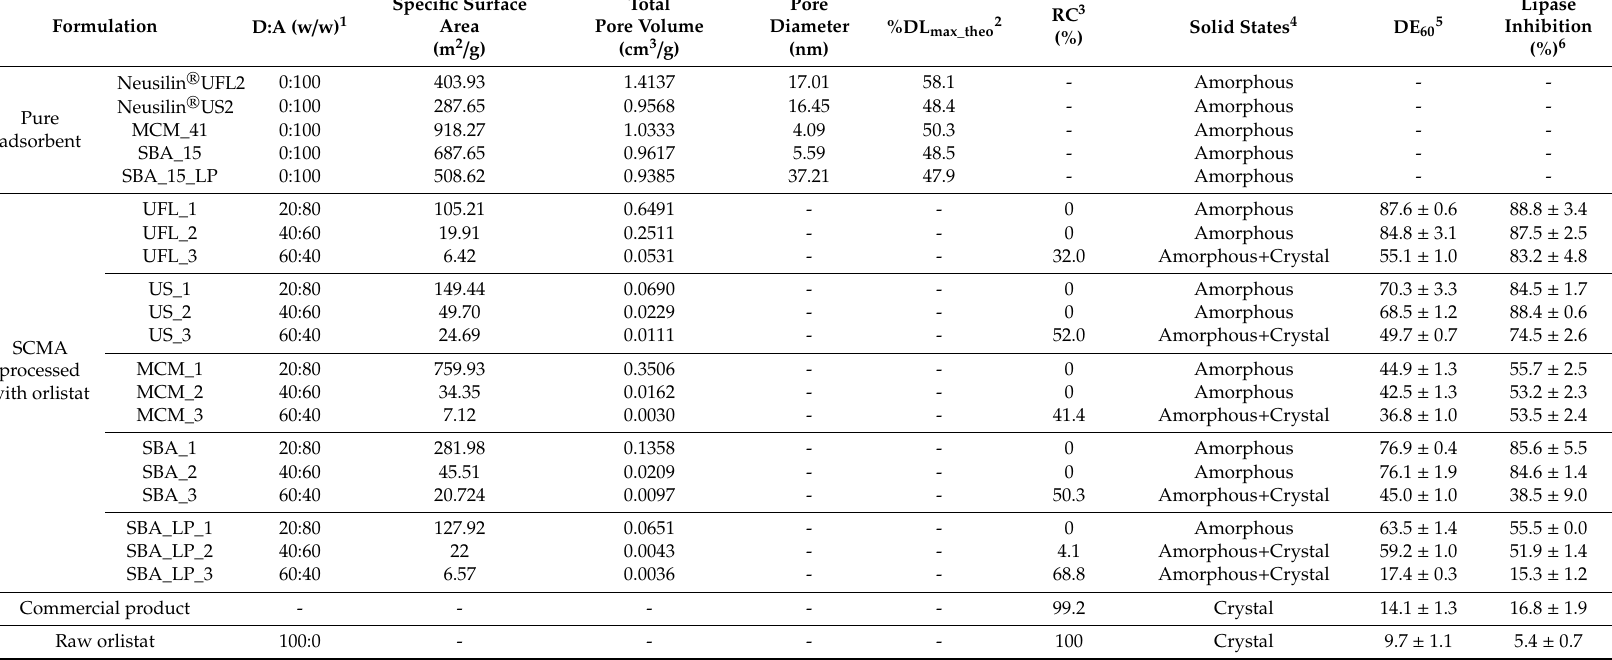
Table 1. Experimental results of raw materials, the commercial product, various mesoporous silica, and orlistat-loaded mesoporous silica. Formulation